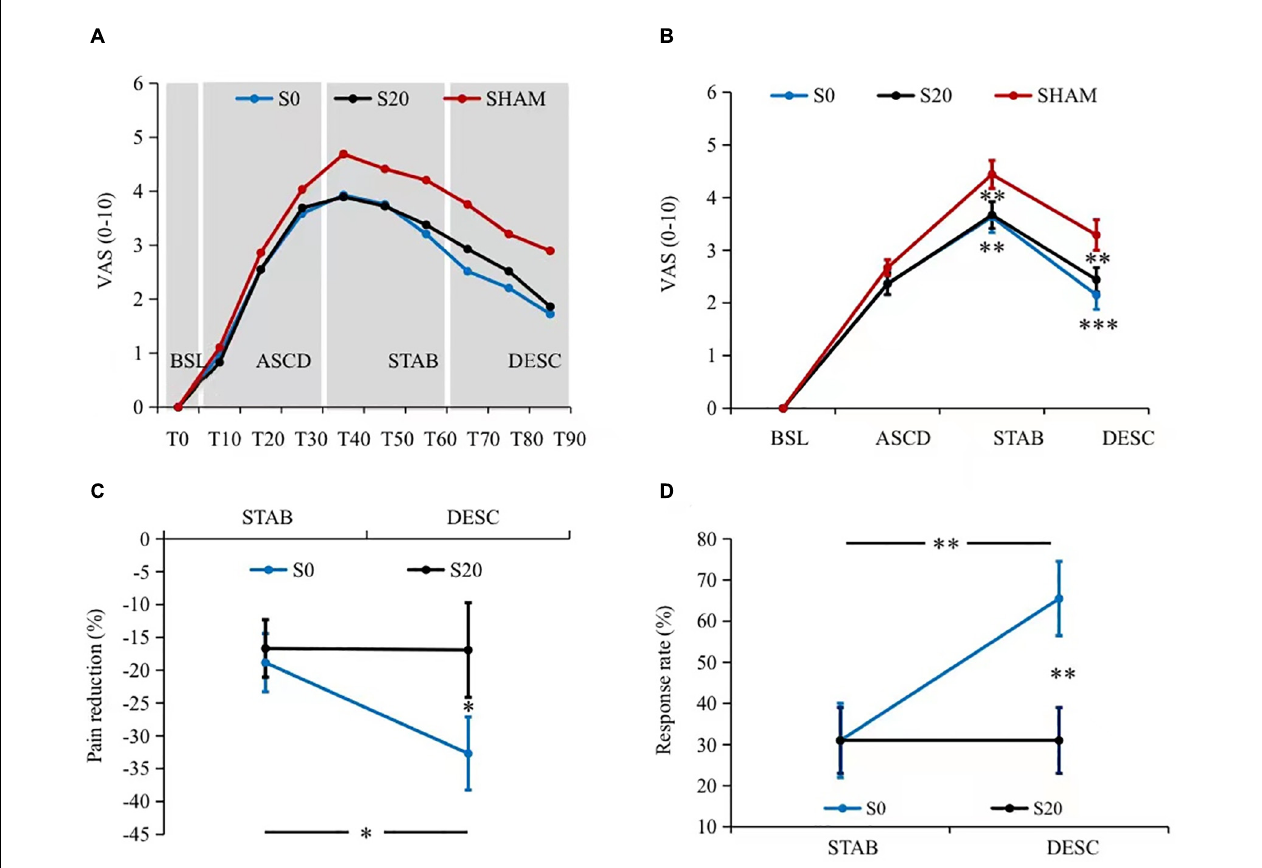
FIGURE 2 | Pain intensity results. (A) The dynamics of pain perception. Pain ratings demonstrated a clear pattern of baseline (T0), ascending (T10–T30, all P corrected < 0.05 compared to the predecessor), stabilizing (T40–T60, all P corrected > 0.05 compared to the predecessor), and descending (T70–T90, all P corrected < 0.05 compared to the peak amplitude T40, and all P corrected < 0.05 compared to the predecessor) phases. In addition, both the S0- and S20-pcTBS decreased pain from T40 to T90 compared to the Sham stimulation. (B) The averaged pain ratings within each phase. Similarly, S0- and S20-pcTBS decreased pain in the stabilizing (all P corrected < 0.05) and descending (all P corrected < 0.05) stages compared to the Sham stimulation. (C) The analgesic efficacy of S0- and S20-pcTBS. S0-pcTBS resulted in a larger pain reduction in the descending phase compared to the S20-pcTBS and that in the stabilizing phase. (D) The results of analgesic efficacy in terms of response rate. S0-pcTBS had a higher response rate in the descending phase compared to the S20-pcTBS and that in the stabilizing phase. ∗ , ∗∗ , and ∗∗∗ denote P < 0.05, P < 0.01, and P < 0.001 compared to the Sham. BSL, baseline; ASCD, ascending; STAB, stabilization; DESC, descending. Please refer to the Supplementary Material for figures with all the samples and